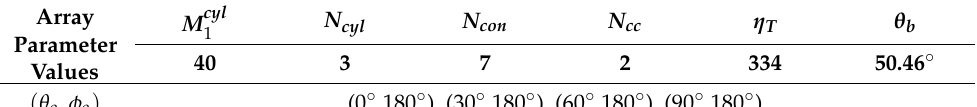
Table 3. CSC 4 arbitrary array parameters for power pattern testing.